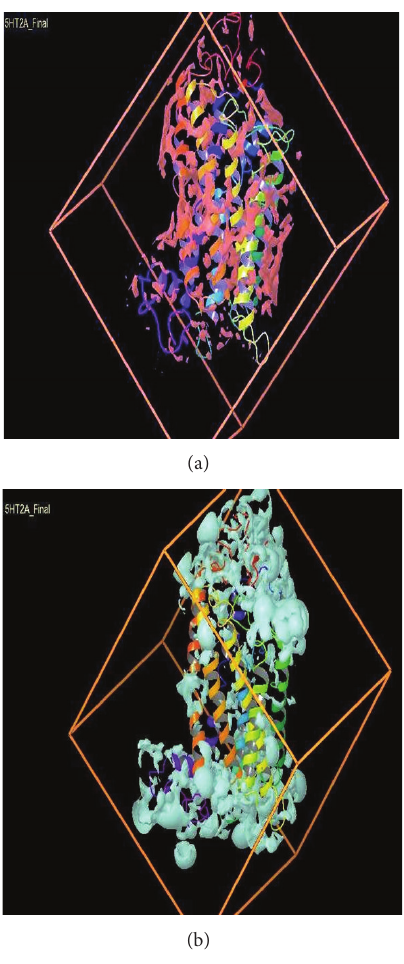
Figure 9: (a) Hydrophobic region and (b) hydrophilic region in modelled 5-HT 2𝐴 receptor.